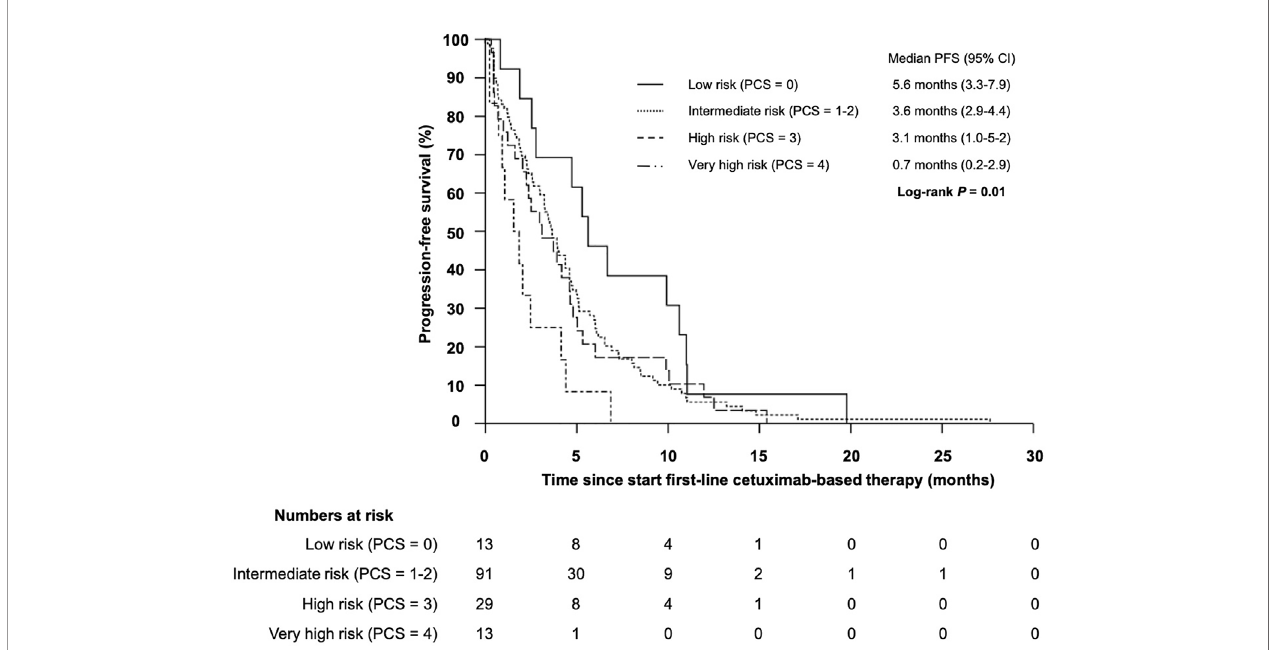
FIGURE 7 | Kaplan – Meier plot for progression-free survival (PFS) for patients with r/m SCCHN from start of fi rst-line cetuximab-based therapy according to the prognostic clinical score for low (PCS = 0 points), intermediate (PCS = 1 – 2 points), high (PCS = 3 points) and very high risk (PCS = 4 points) groups (log-rank P =